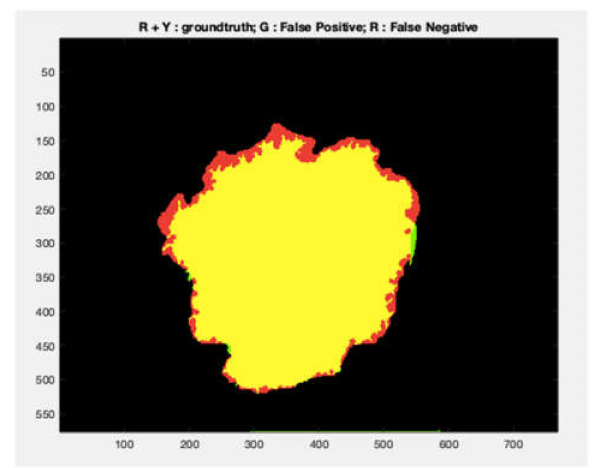
Figure 5. Original lesion with contours of the detected areas, segmented lesion adopting